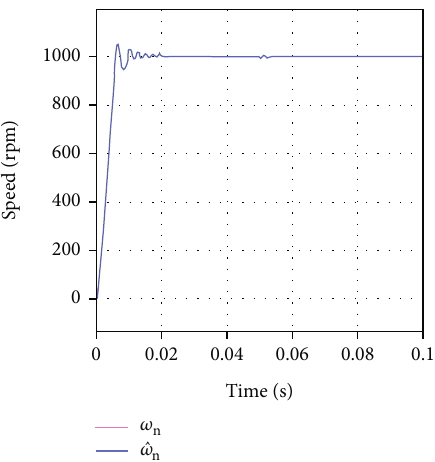
Figure 23: Estimated speed and actual speed for proposed